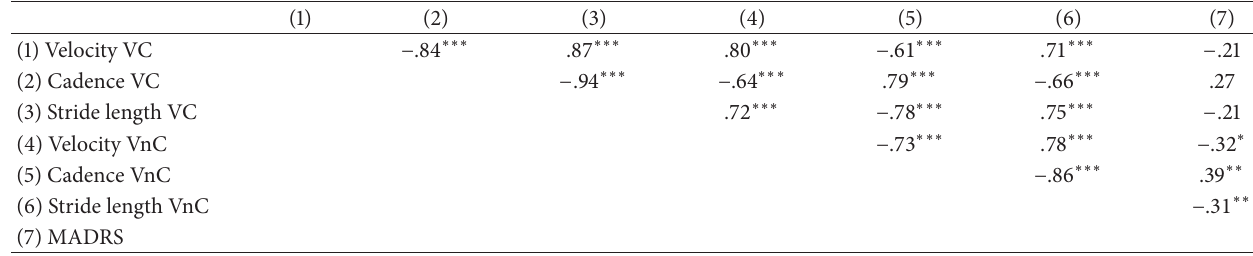
Table 2: Pearson’s correlation of gait characteristics and affective scales in the healthy control group in two conditions (VC =